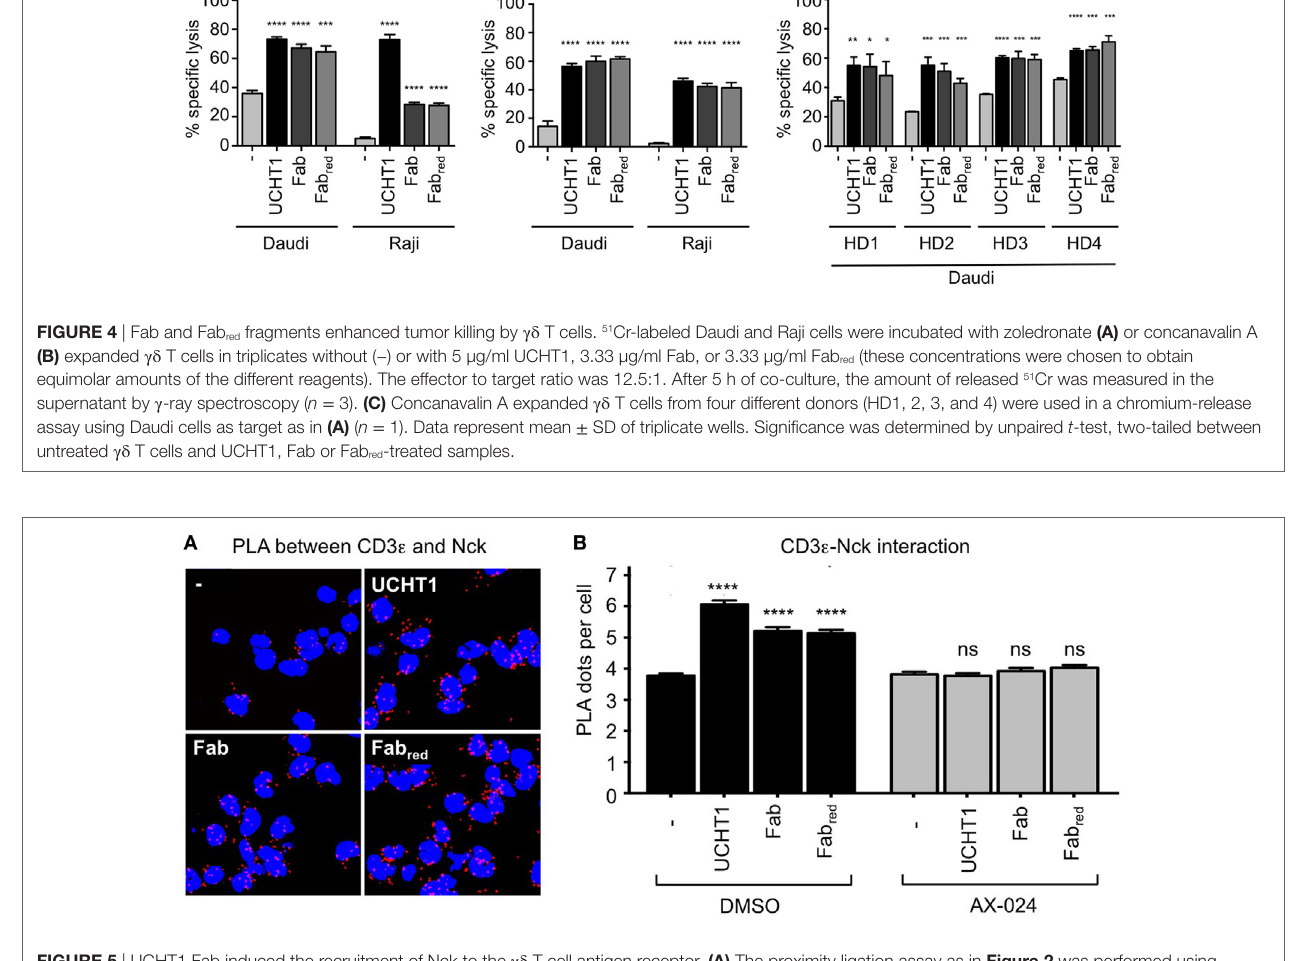
FigUre 5 | UCHT1 Fab induced the recruitment of Nck to the γδ T cell antigen receptor. (a) The proximity ligation assay as in Figure 2 was performed using 5 µg/ml UCHT1, 3.33 µg/ml Fab, and 3.33 µg/ml Fab red in the absence or presence of 10 nM AX-024. (B) The data of (a) were analyzed as in Figure 2F ; 700 cells were analyzed per condition. Two independent experiments were performed ( n = 2).